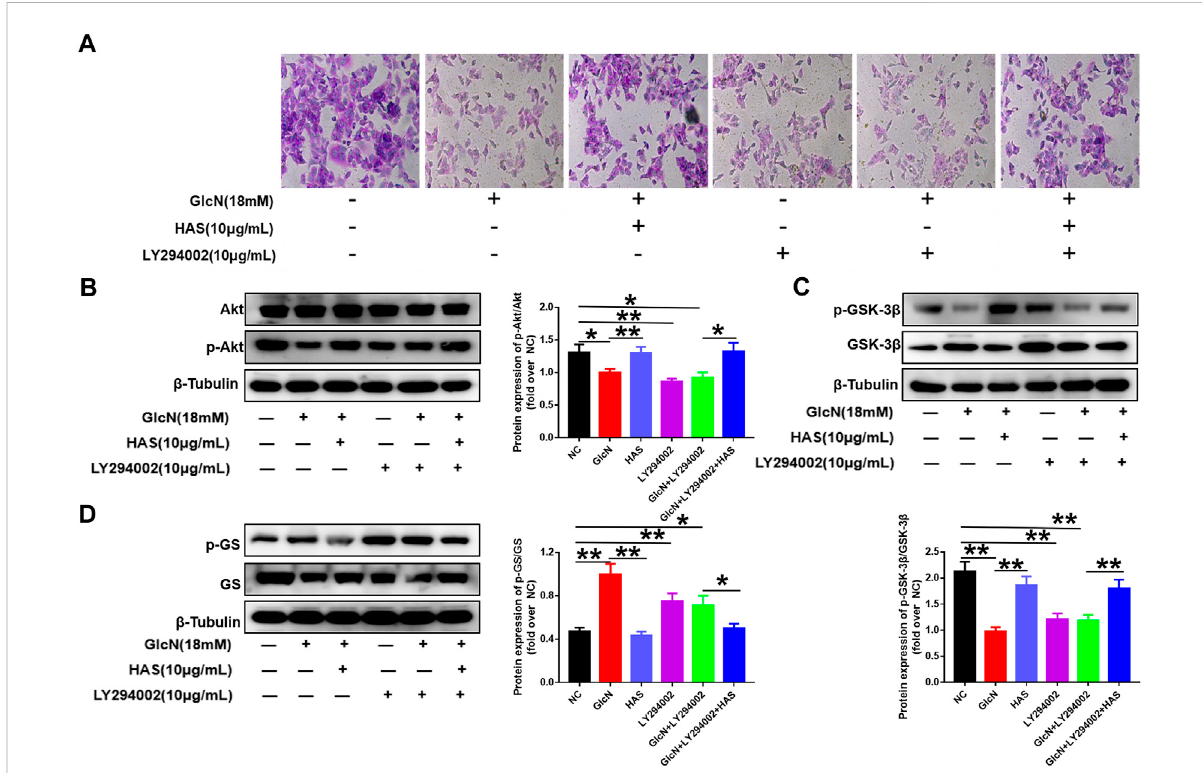
FIGURE 6 Effects ofthePI3K inhibitorLY294002 on glycogen content andPI3K/Akt/GSK-3 β signaling inGlcN-induced HepG2 cells. (A) The effectofHAS in promoting glycogen increase in GlcN-induced HepG2 cells was inhibited by the PI3K inhibitor LY294002. (B – D) The activation of the PI3K/Akt/ GSK-3 β pathway by HAS in GlcN-induced HepG2 cells was inhibited by the PI3K inhibitor LY294002. Data are expressed as mean ± SD ( n = 3), * p